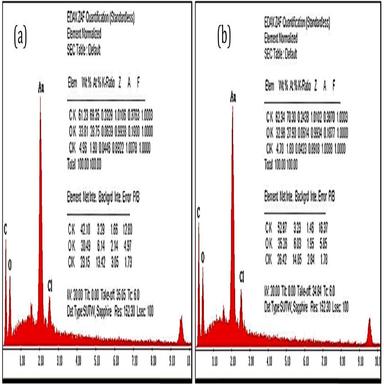
EDX spectra of functionalized CNT/PANI nanocomposites film in the PVA matrix for (a) unirradiated and (b) irradiated at 50 kGy.